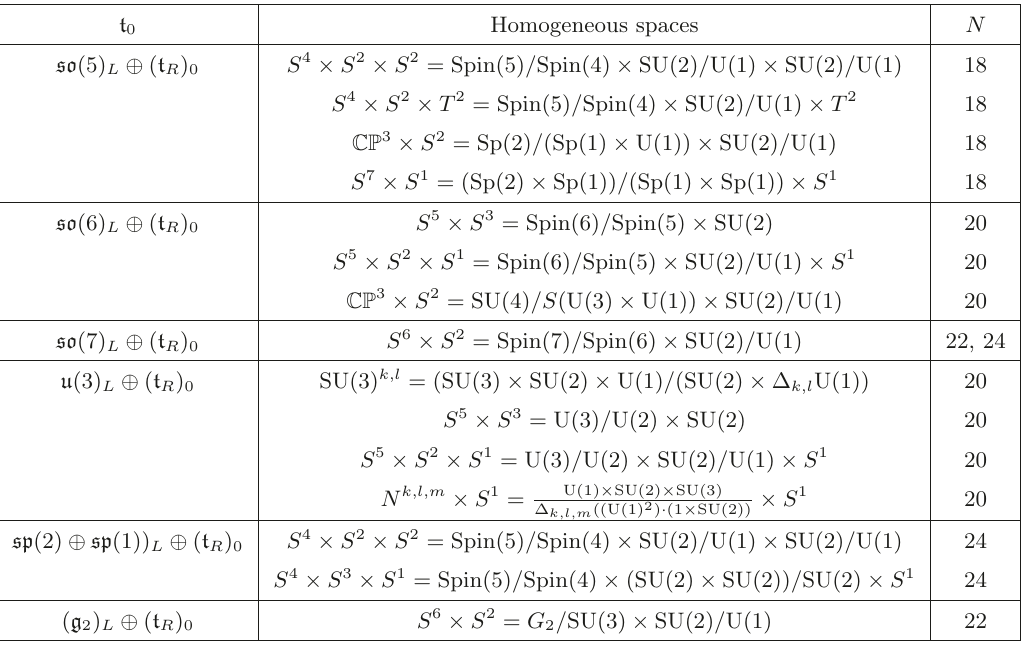
Table 7 . Homogeneous spaces for N R =